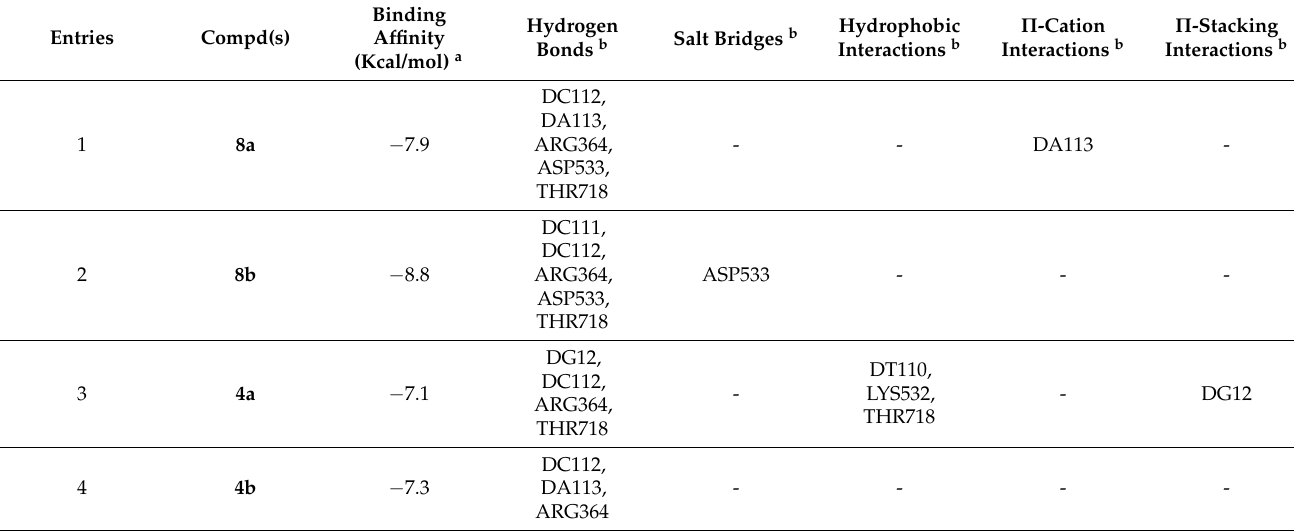
Table 6. Docking analysis for the compounds 8a - b and 4a - b